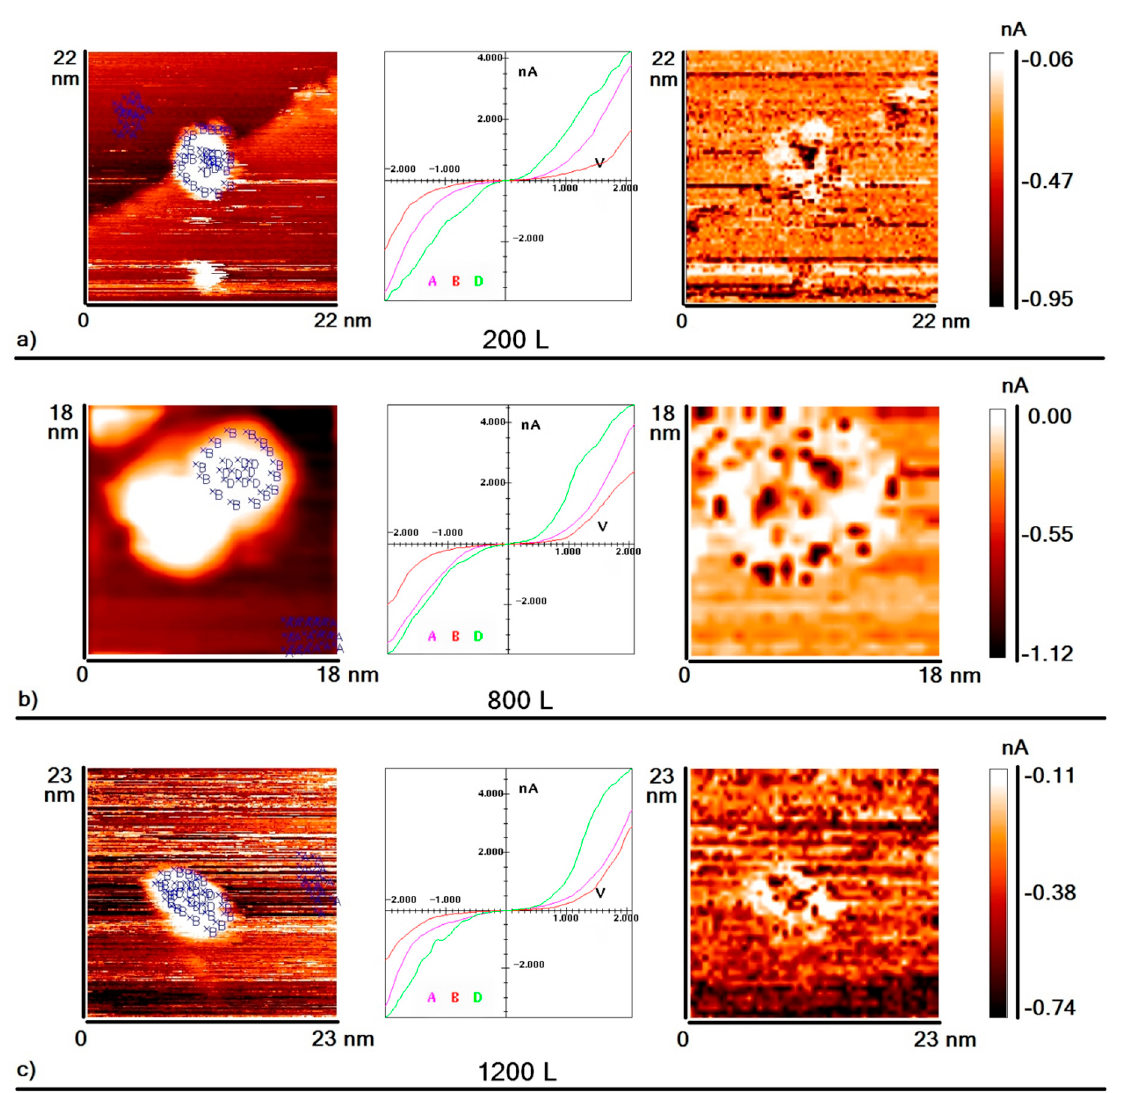
Figure 2. Figure 2. Topography image, VAC, and current image of gold nanoparticles and HOPG at different experimental stages. The letter designation of the curves corresponds to the points on the topography. After exposure to deuterium: ( a ) 200 L; ( b ) 800 L; ( c ) 1200 L.